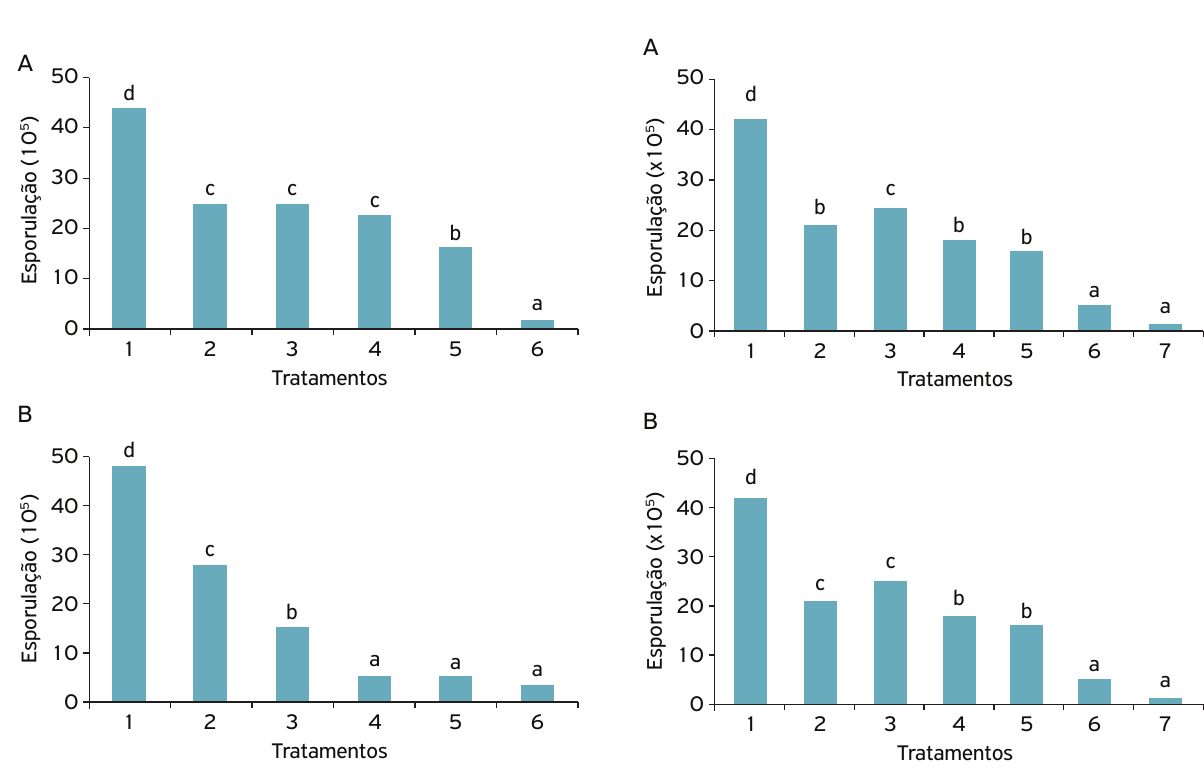
Figura 2. Efeito da fração volátil do óleo de café verde na redução da esporulação de Penicillium roqueforti (A) e Rhizopus stolonifer (B). Tratamentos: 1) controle; 2) álcool; 3) óleo de café verde (OC) 500 μ L L -1 ; 4) OC 1.000 μ L L -1 ; 5) OC da-índia 800 μ L L -1 . Letras distintas representam diferença significativa entre os tratamentos pelo teste de Scott-Knott a 5% de probabilidade.